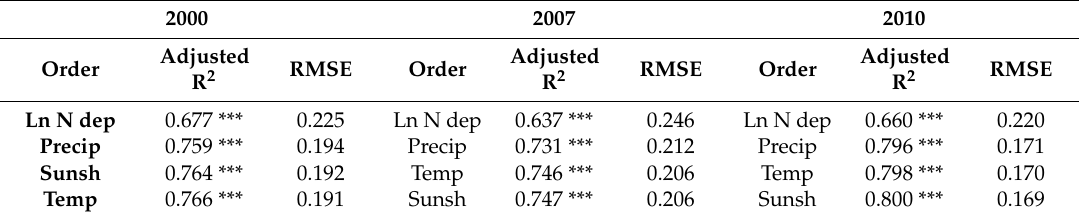
Table 4. Order of variables entered into the model and adjusted R 2 for grasslands, according to the addition of a new variable to the model: Ln N dep: Natural logarithm of N deposition, Temp: Temperature, Precip: Precipitation, and Sunsh: Sunshine. *** Statistically significant p <